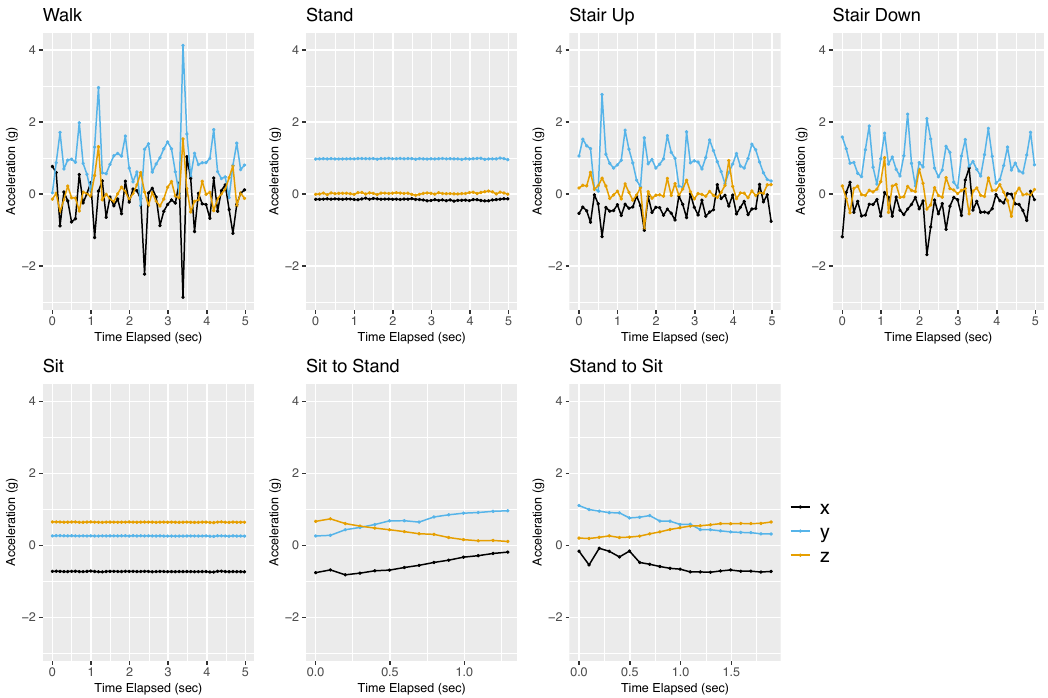
Figure 1. Accelerometer training data for participant 1. This figure shows the accelerometer training data for participant 1. The accelerometer measures the acceleration of the smartphone along the x , y , and z axes. The acceleration data are measured in units of g (i.e., 9.81 m/s 2 ). The x -axis is shown in black, the y -axis in blue, and the z -axis in orange.